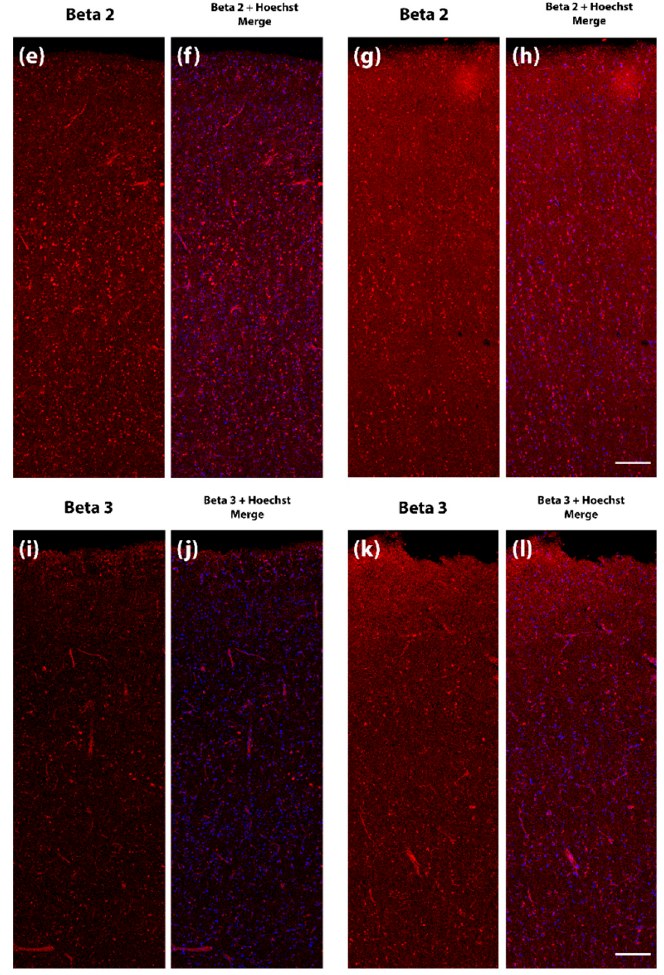
Figure 2. Representative fluorescent immunohistochemistry images from the human Alzheimer’s disease and control middle temporal gyrus (MTG). Post-mortem human MTG sections were labelled with antibodies against GABA A R subunits and imaged with uniform settings for each subunit on a confocal microscope. GABA A R subunits are presented in red and Hoechst staining is presented in blue. A reduction in fluorescent intensity across cortical layers was apparent for the α 1 subunit (cases AZ90 and H122 presented) ( a – d ), β 2 subunit (cases AZ90 and H122 presented) ( e – h ) and β 3 subunit (cases AZ90 and H181 presented) ( i – l ). Scale bar, 200 µm.